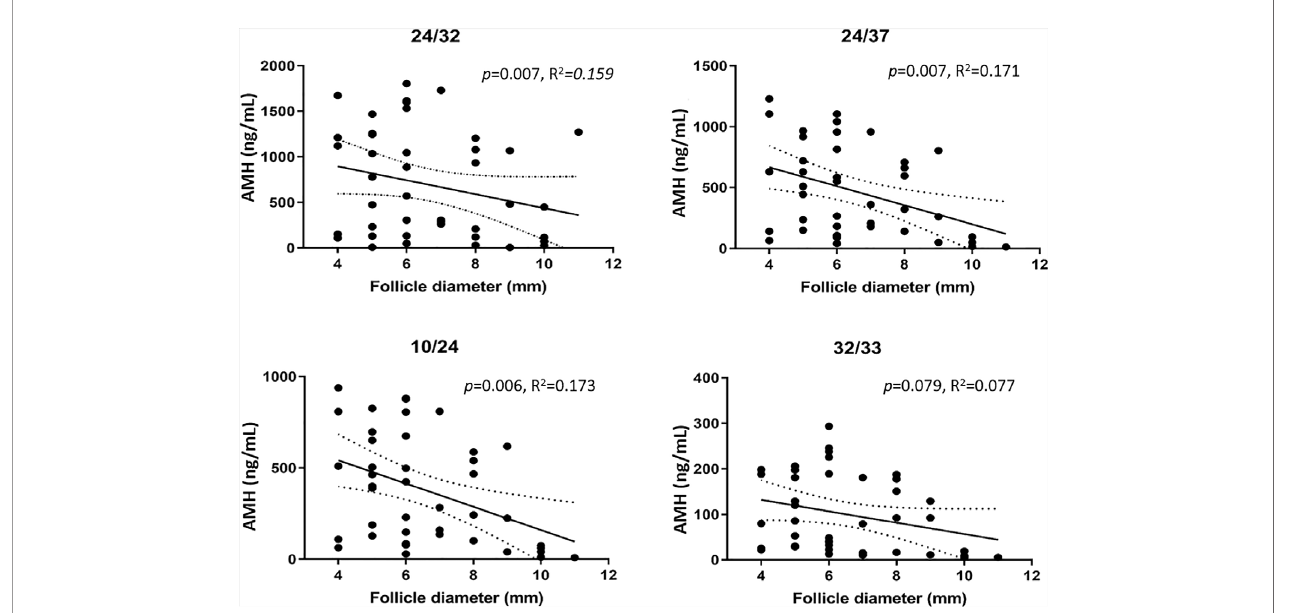
FIGURE 2 | AMH concentrations measured with four different ELISAs in FFs from small antral follicles in relation to follicle size (4-11 mm). A signi fi cant negative correlation between AMH concentration and follicle size was detected with assays 24/32, 24/37, and 10/24 (Ansh Labs, LLC, Webster, TX, USA). The solid line indicates the mean AMH concentrations in relation to follicle diameter. Dotted lines indicate 95% con fi dence intervals.